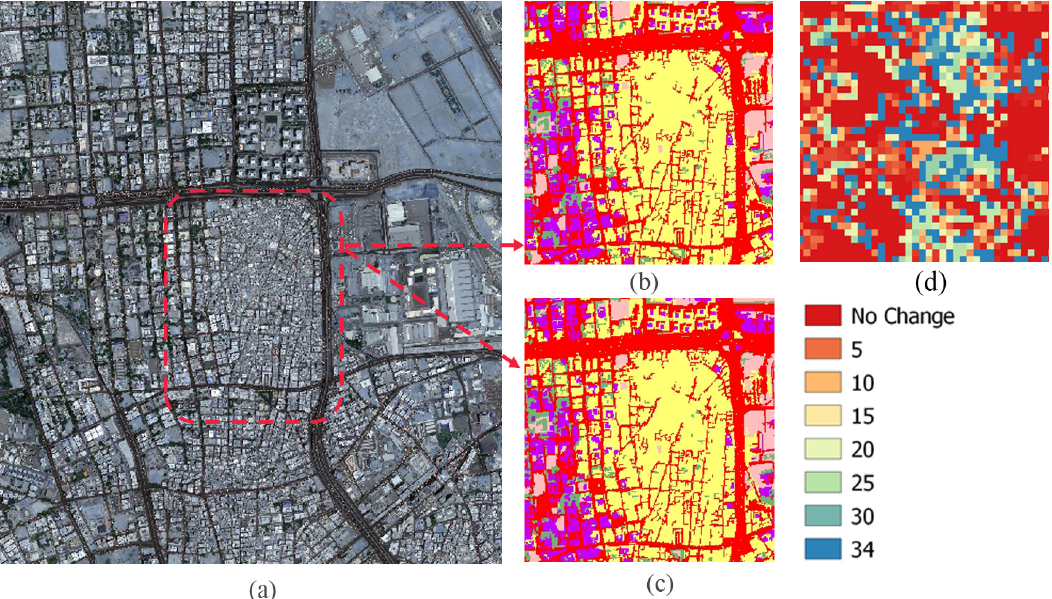
Figure 7. The main difference between formal and informal road networks. ( a ) A GeoEye-1 image ( b ) shows mapping results without TSA, while ( c ) shows the mapping results using TSA. The result shows an improvement in the connectivity of road network and enhancing road widths. ( d ) The year-of-change results inside an informal settlement.